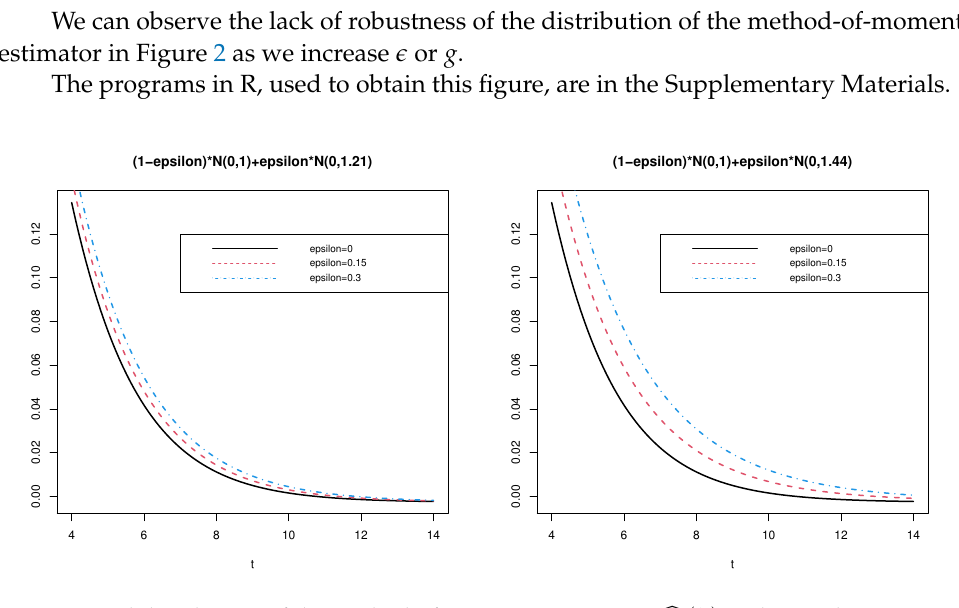
Figure 2. Tail distribution of the method-of-moments estimator 2 (cid:99) γ ij ( h ) with sample size N h = 3 and two underlying models: ( 1 − (cid:101) ) N ( 0,1 ) + (cid:101) N ( 0,1.1 2 ) and ( 1 − (cid:101) ) N ( 0,1 ) + (cid:101) N ( 0,1.2 2 ) , for three different degrees of contamination (cid:101)